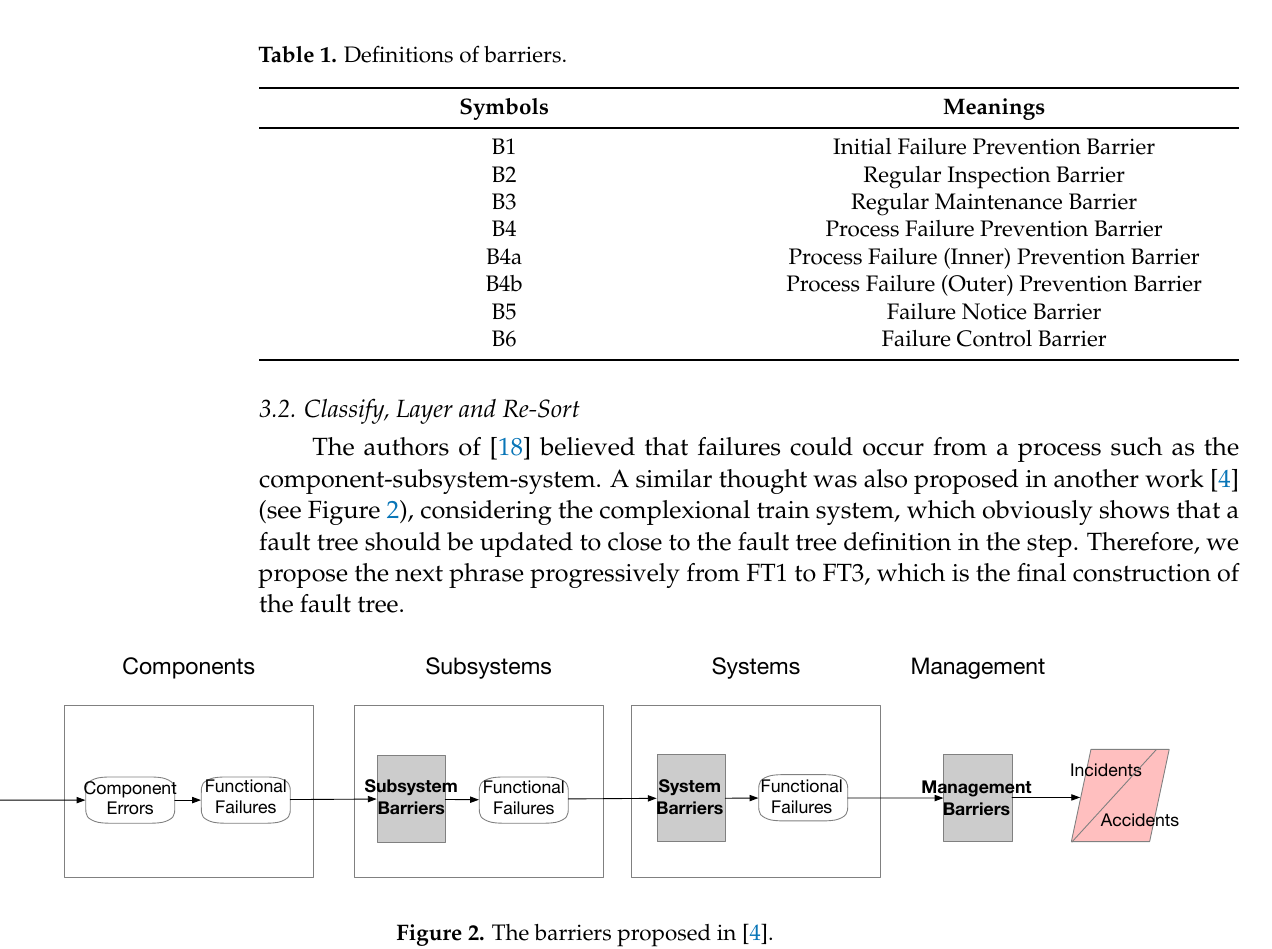
Figure 2. The barriers proposed in